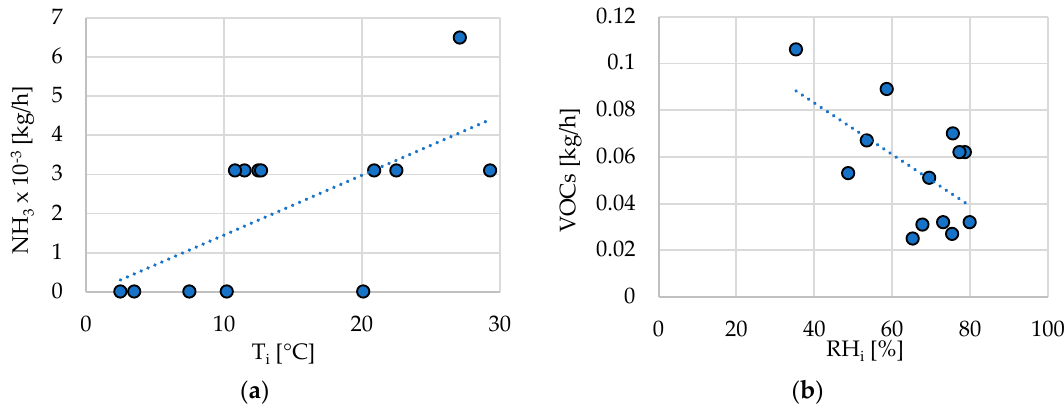
Figure 14. Correlation diagrams between emission from roof ventilators at biogas plant A and measured microclimatic parameters, with regression lines: ( a ) R 2 = 0.35, ( b ) R 2 = 0.43.